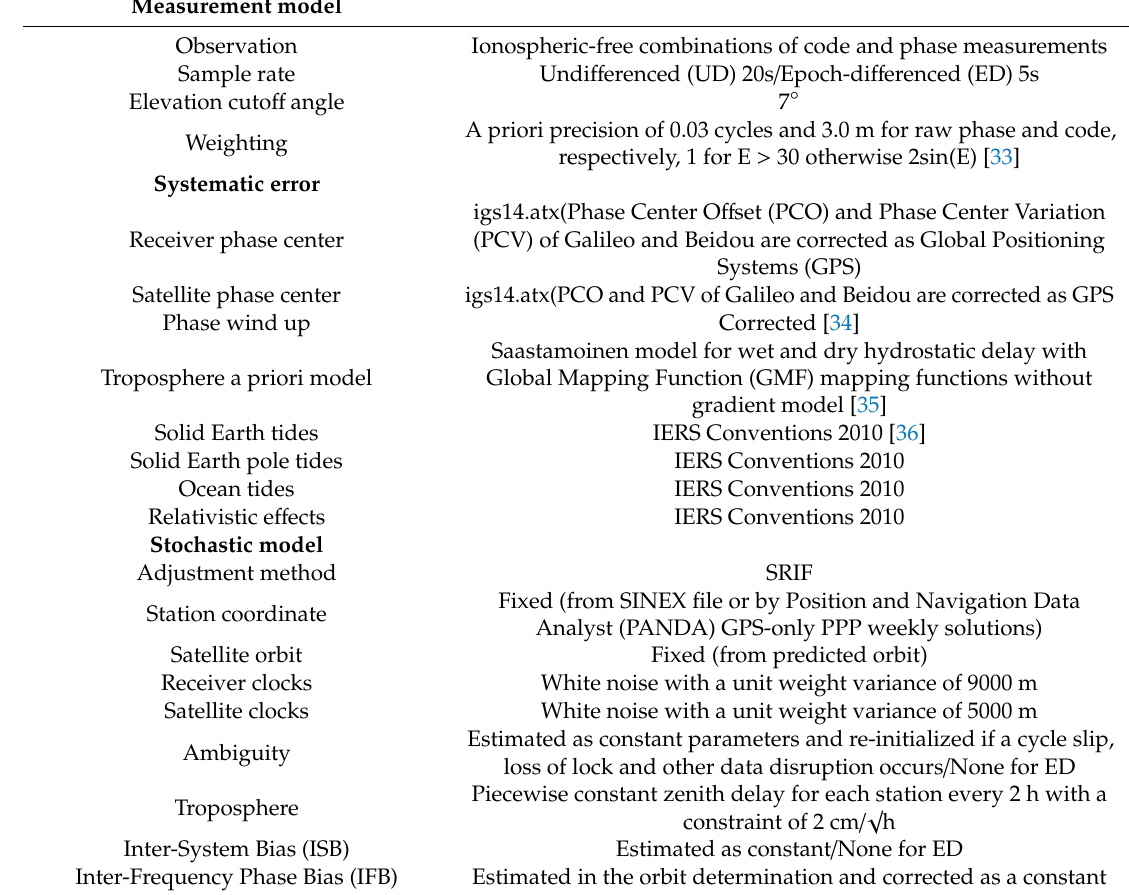
Table 3. Observation models involved in clock estimation.